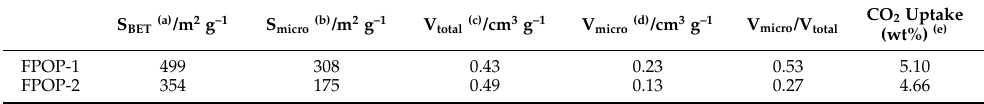
Figure 6. Nitrogen adsorption (close symbols) and desorption (open symbols) isotherms of FPOP-1 and FPOP-2 measured at 77 K ( a ); pore size distribution curves of FPOP-1 and FPOP-2 calculated by NL-DFT ( b ). Table 1. Porosity data of FPOP-1 and FPOP-2.